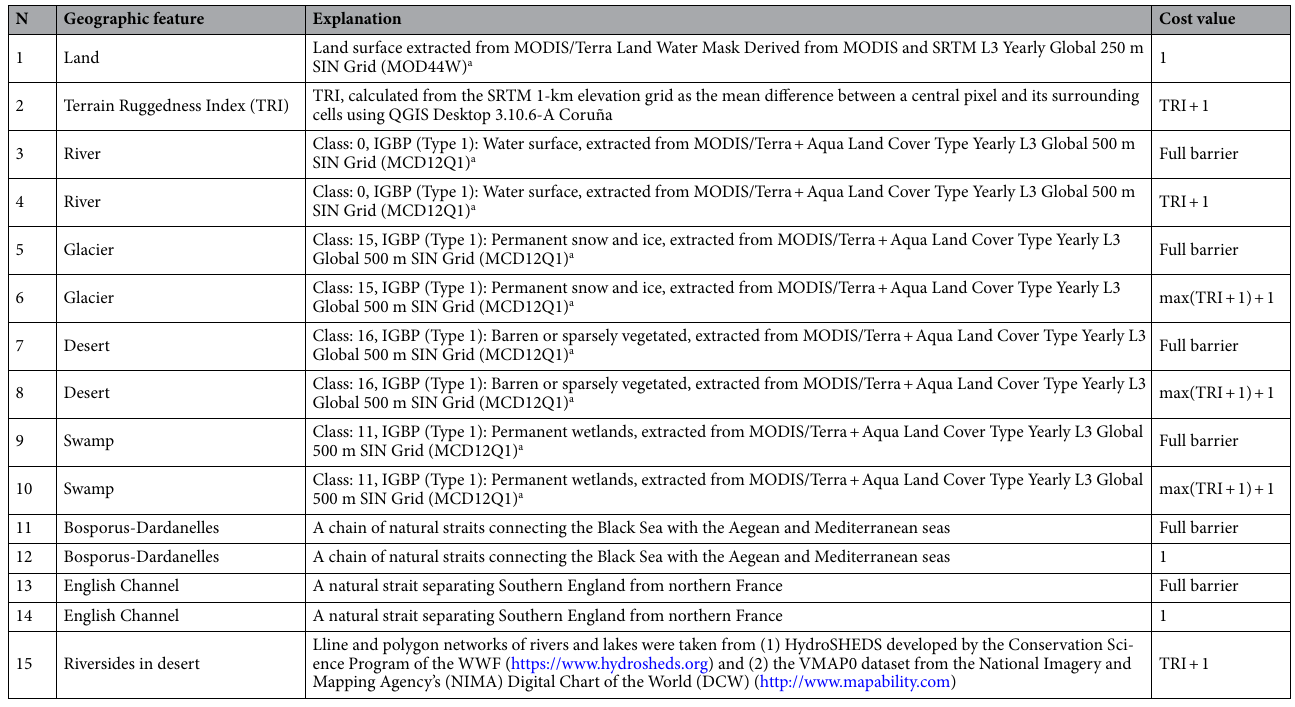
Table 3. Geographic features used in combinations to calculate least-cost distances (LCD) between ancient populations and modern Caucasians. a Obtained from https:// search. earth data. nasa. gov/